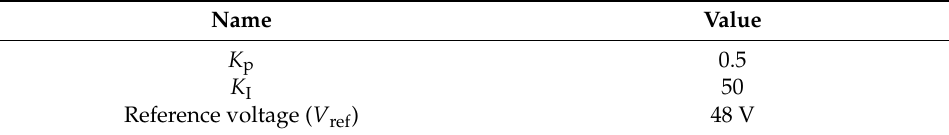
Table 4. Key ratings in control circuit.